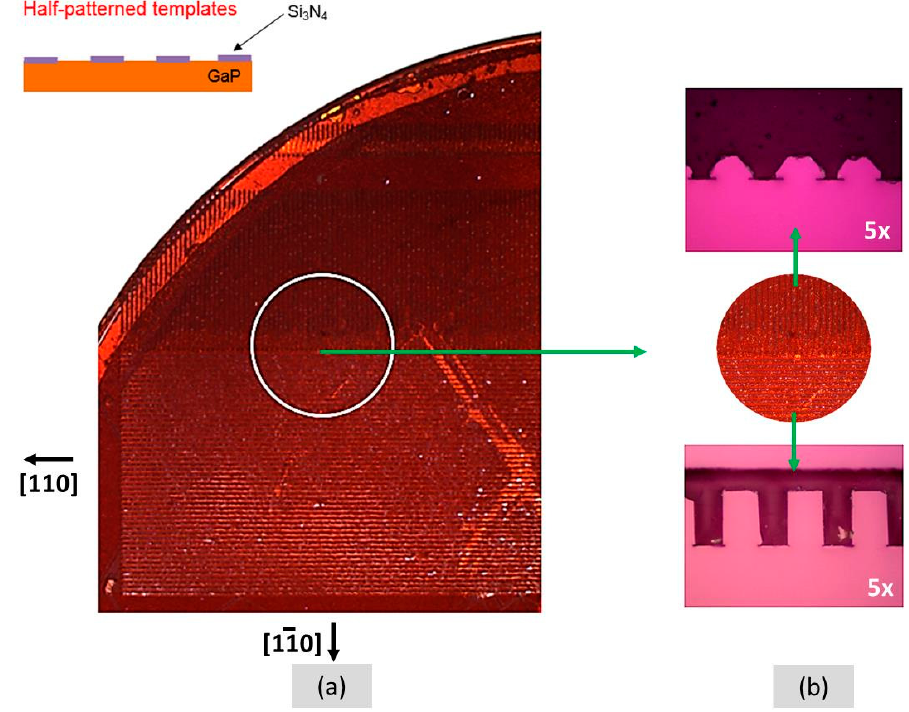
Figure 22. ( a ) Two half-patterns deposited in two mutually perpendicular directions; and ( b ) cross section images of the layers grown on them [63]. (Reproduced from [63] with the permission of SPIE).